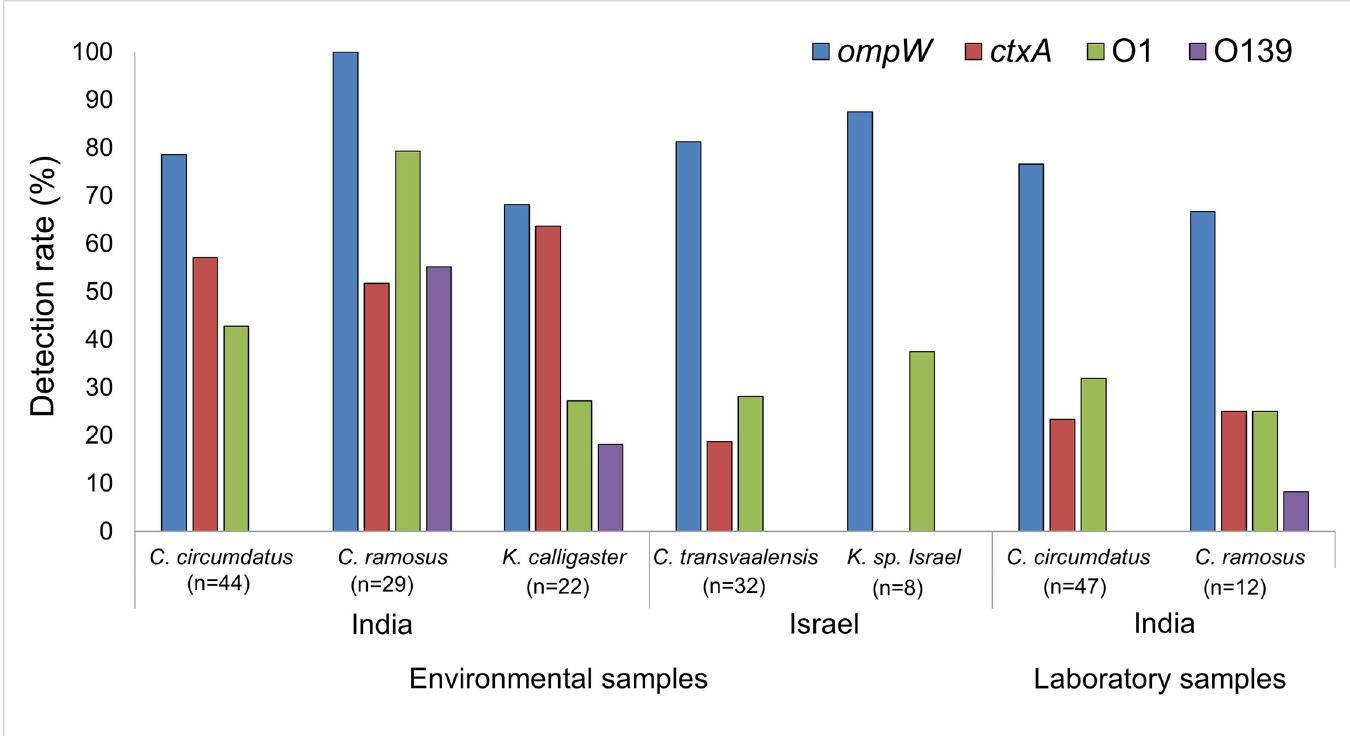
Fig 2. Detection rates of virulence genes and toxigenic V . cholerae serogroups at all sampling sites. To increase clarity, specimens of species with two or fewer individuals were not included in the figures and calculations. n, the total number of individuals.